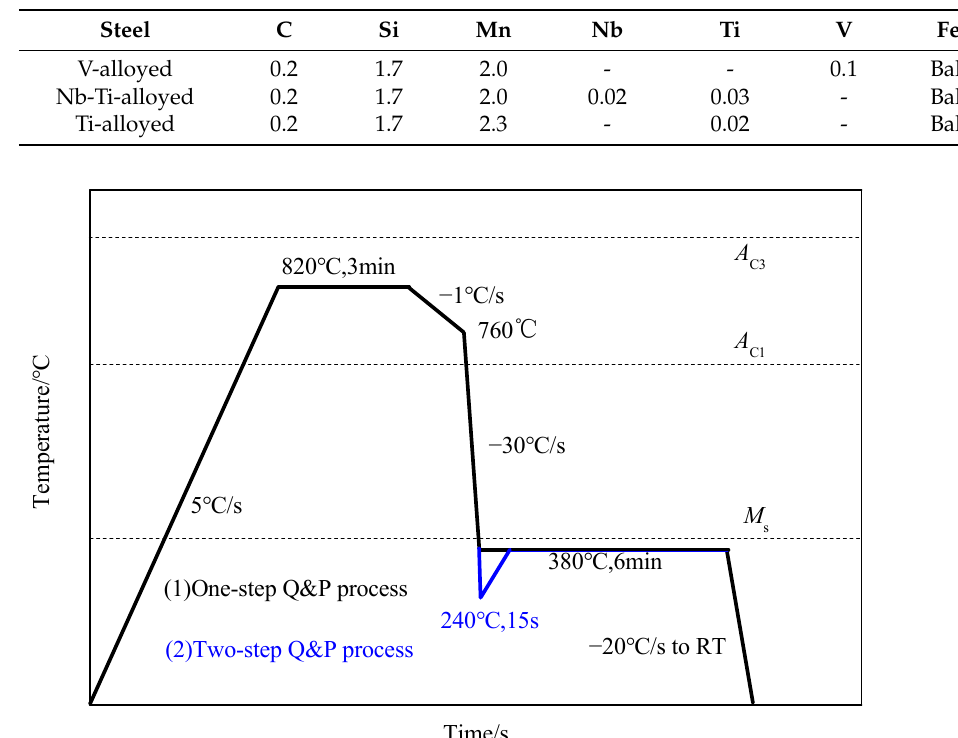
Table 1. Chemical compositions of designed steels (wt.%).